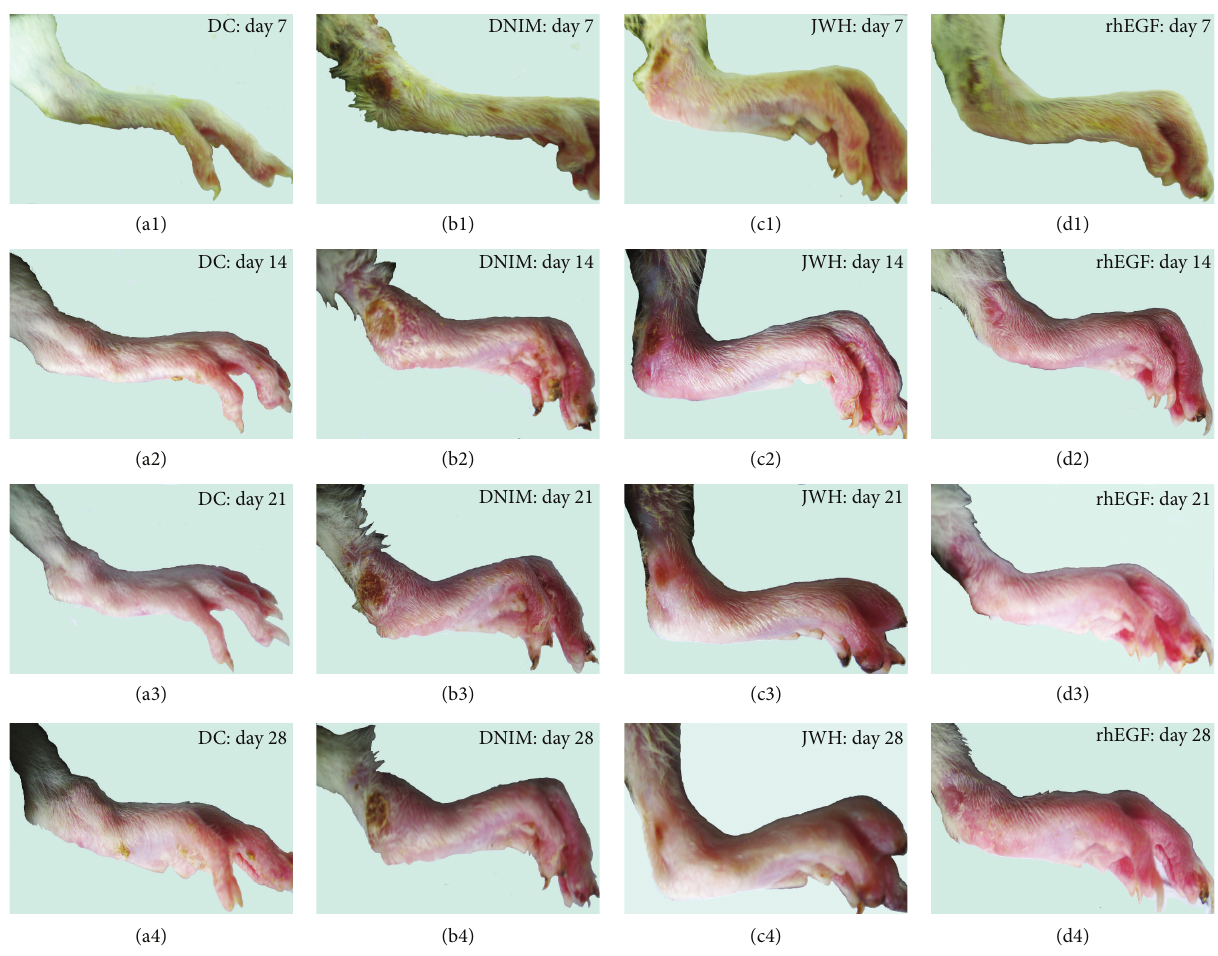
Figure 2: Results of macroscopic observation. These were the photographs of nerve injury diabetic foot of all groups on day 7 (before administration) and days 14, 21, and 28 (after ministration). Each figure was indicated by the foot ulcer. (a1–a4) showed the integral skin of DC group; (b1–b4) showed the foot ulcer changes in DNIM group on days 7, 14, 21, and 28. (c1–c4) showed the foot ulcers forming in the JWH group on day 7 (before administration) and days 14, 21, and 28 (after administration). (d1–d4) showed the foot ulcers forming in the rhEGF group on day 7 (before administration) and days 14, 21, and 28 (after